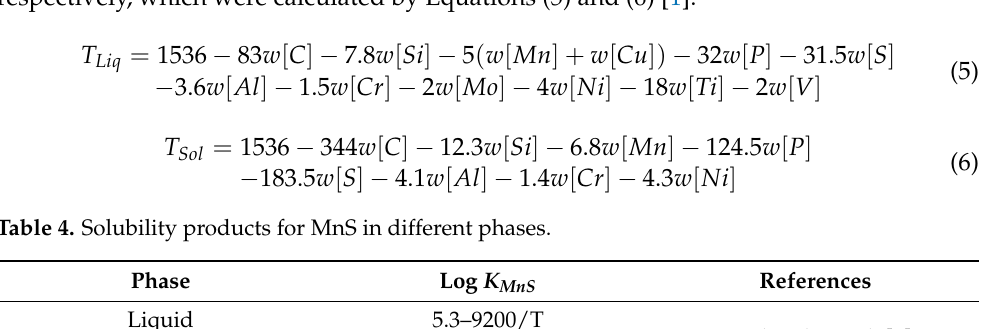
in Table 5. The liquidus and solidus temperature of the 45# steel are 1766 K and 1642 K, respectively, which were calculated by Equations (5) and (6) [1].